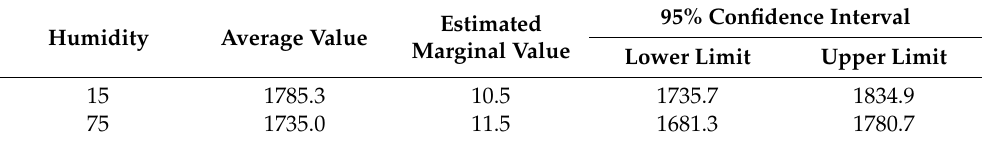
Table 8. Analysis of the effect of water–ash ratio factors on the shrinkage of 28-day foamed concrete. Water-Cement